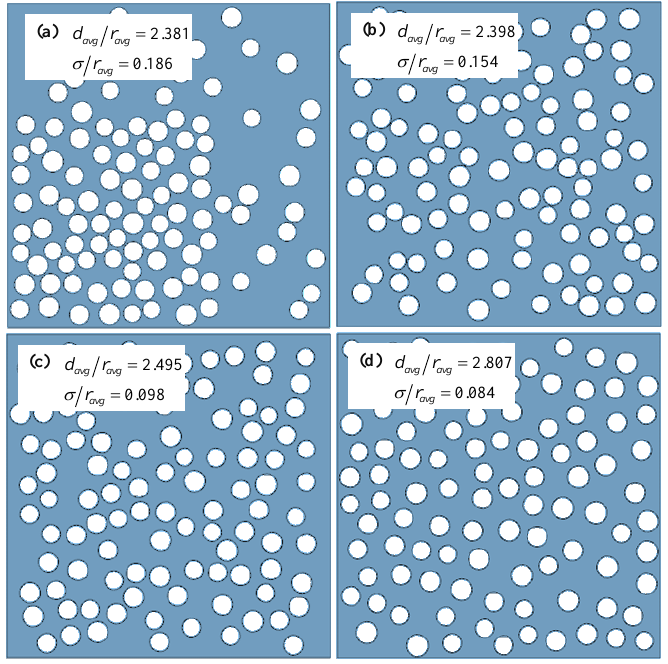
Figure 10. Porous membrane RVEs with controlled porosity dispersion.